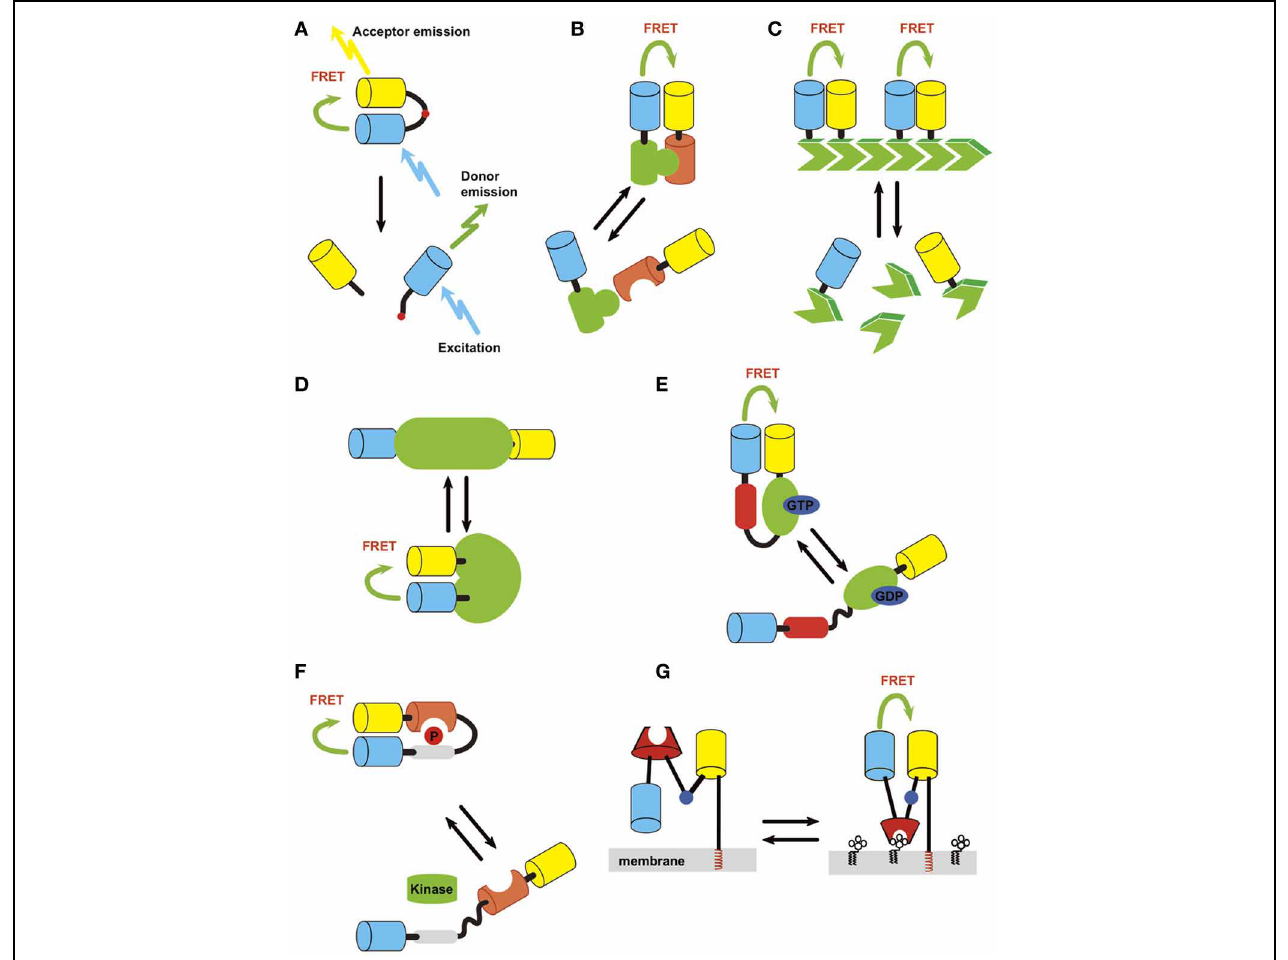
An example of detection of small GTPase activation (green) by small GTPase binding protein (red) is shown. (F) Conformation change of fusion protein induced by covalent modification/inactivation. Here an example of detection of kinase activity by substrate sequence (gray) and phosphoprotein binding domain (orange) is depicted. (G) Small molecule on membrane